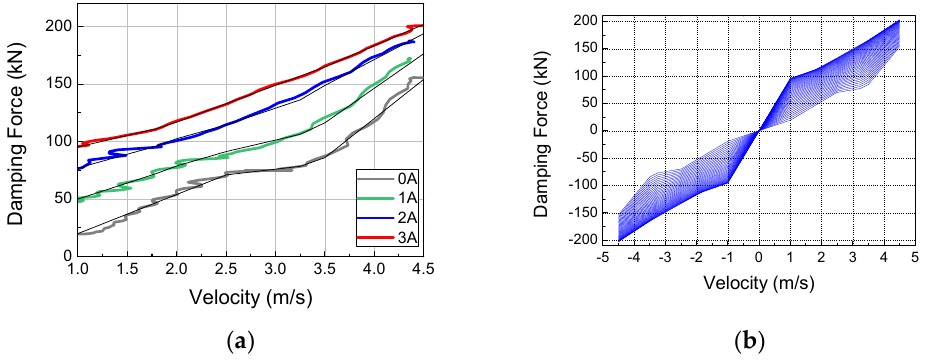
Figure 10. F-V curve (Test. 4). Table 2. Values of the coefficients for the estimation of the F-V model with different inputs. Vel. [m/s]